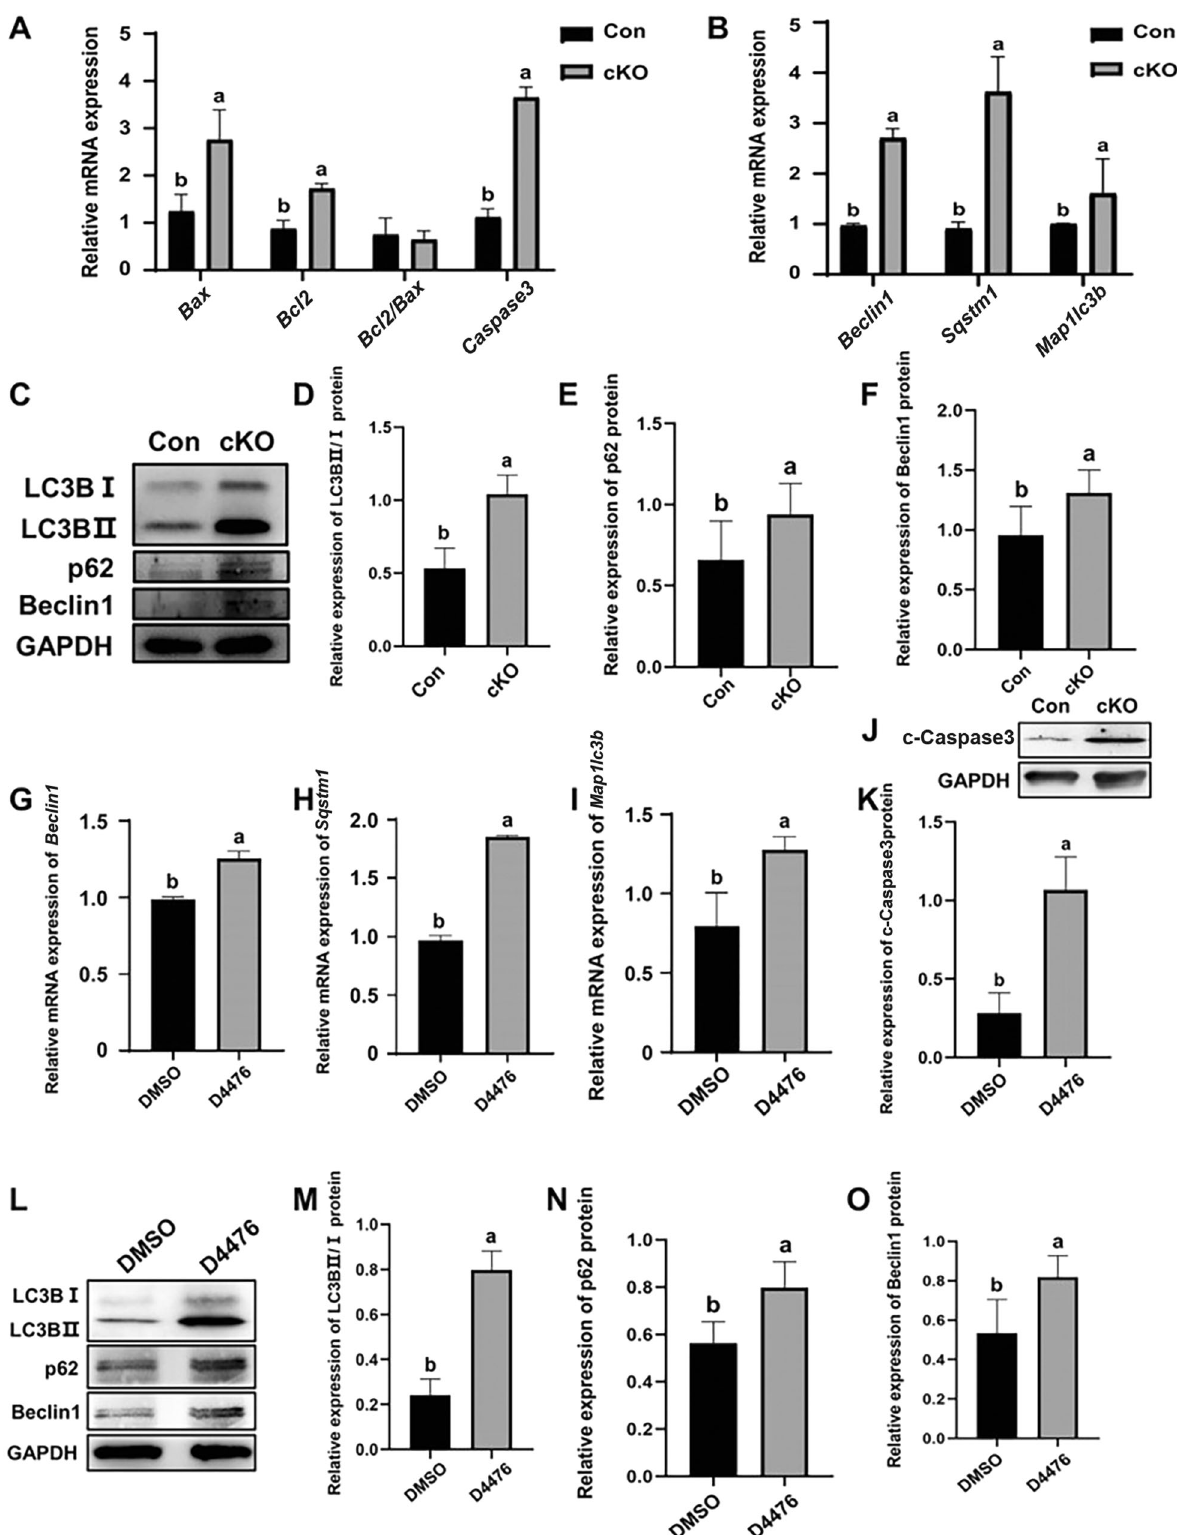
Fig. 6 Effects of CK1 α inactivation on the gene and protein expressions related to cell apoptosis and autophagy in mouse ovaries. A , B Respectively, RT-qPCR analysis of apoptotic and autophagy gene expression levels in 1 dpp mouse ovaries. Map1lc3b (gene encoding LC3B), Sqstm1 (gene encoding p62). Results were presented as means ± SEM ( n = 3). C Western blot analysis and D – F relative expression levels of LC3BII/I, p62, and Beclin1 protein in 1 dpp ovaries. G – I RT-qPCR analysis of Map1lc3b , Sqstm1 , and Beclin1 mRNA expression levels in 15.5 dpc embryo ovaries treated with 25 µM D4476 for 4 days (15.5 dpc + 4 days). J – O Relative expression of cleaved-Caspase3 (c-Caspase3), LC3BII/I, p62, and Beclin1 protein levels in 15.5 dpc + 4 days ovaries detected by western blot. Different letters indicate that the difference is signi fi cant ( P < 0.05). The values are the means ± SEM of three independent